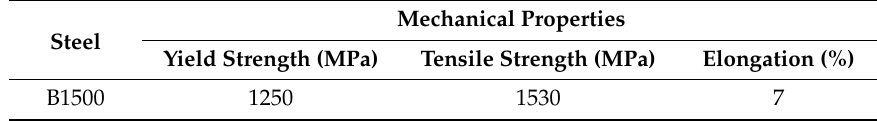
Table 2. Mechanical properties of B1500